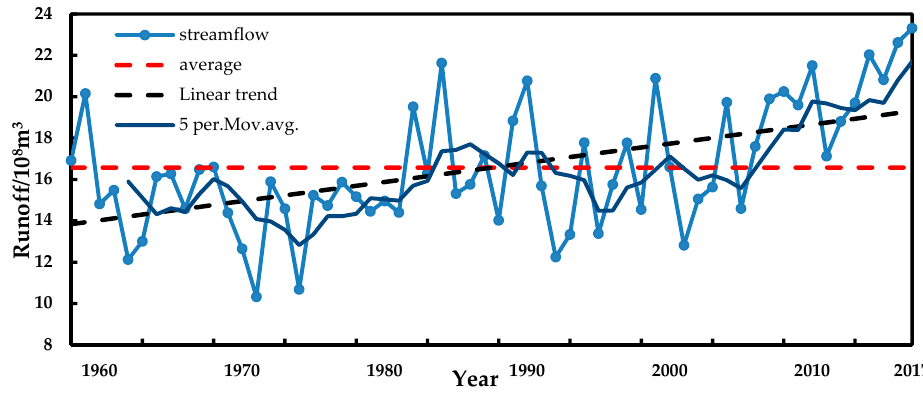
Figure 4. Trend analysis of runoff at Yingluoxia station.